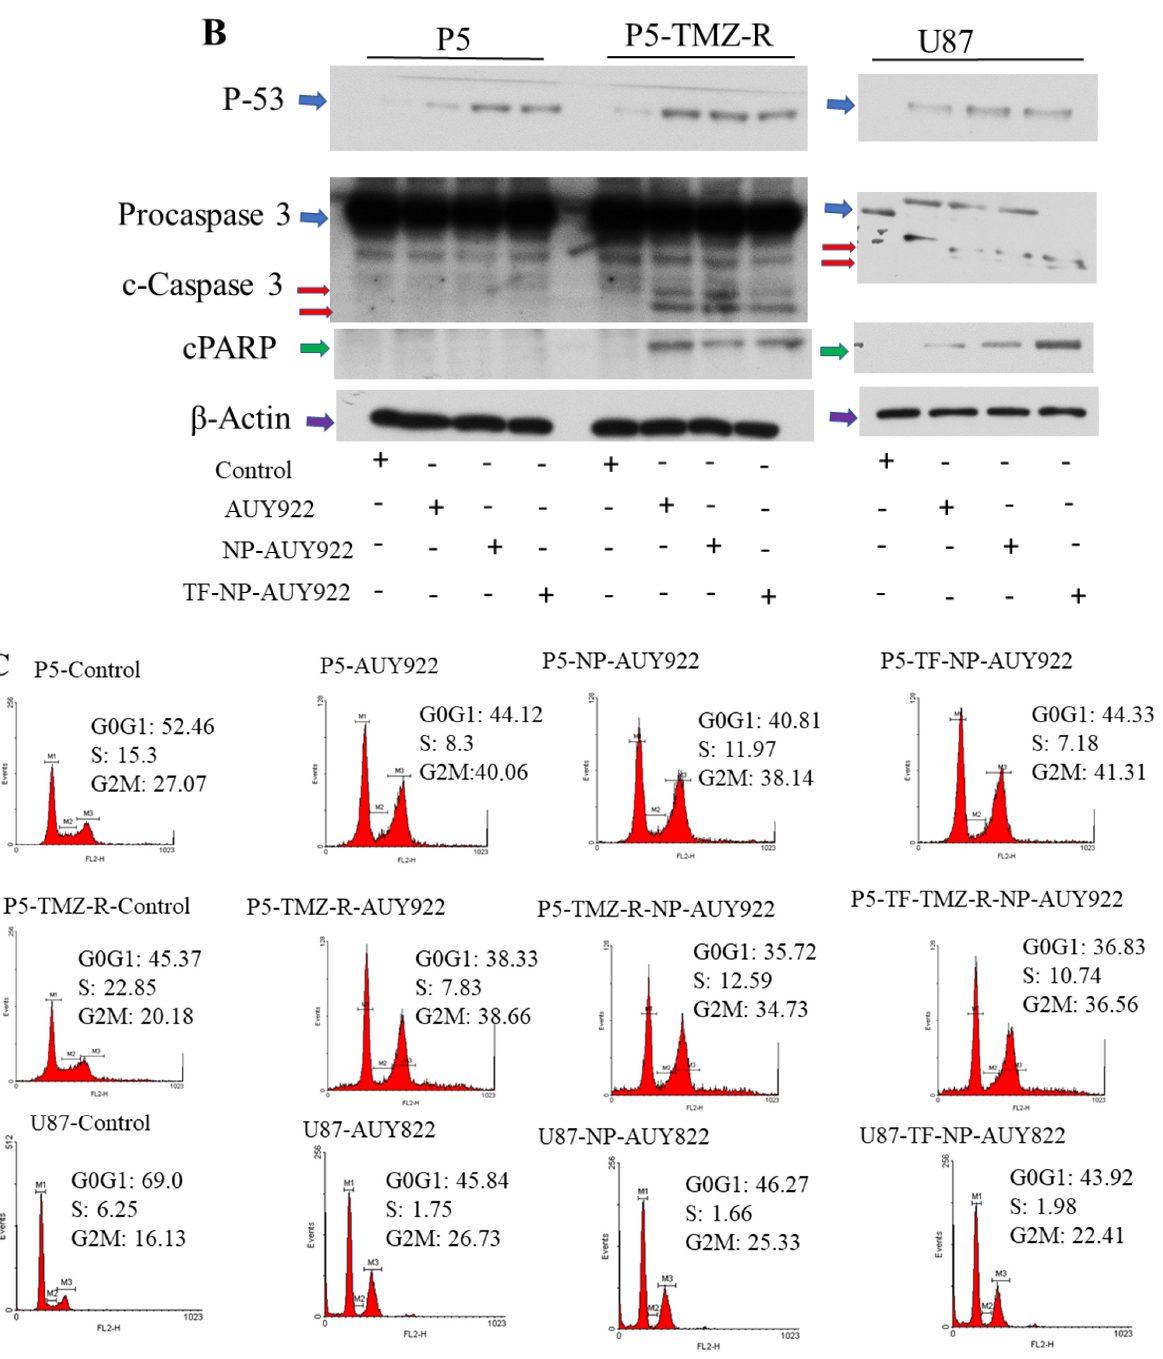
Figure 5. ( A ) Apoptosis assay of free AUY922, NP-AUY922, and TF-NP-AUY922 after 72 h of incubation at a concentration of 100 nM for free or nanoformulated AUY922. ( B ) Expression of P53, activation of caspase 3 (cleaved caspase 3), activation of PARP (cPARP) and β -actin proteins in P5, P5-TMZ-R, and U87 brain cancer cells after treating for 48 h using 100 nM free AUY922, NP-AUY922, and TF-NP-AUY922. ( C ) Cell cycle analysis of free AUY922, NP-AUY922, and TF-NP-AUY922 using P5, P5-TMZ-R, and U87 brain cancer cells after 48 h of incubation at a concentration of 100 nM for free or nanoformulated AUY922. In ( B ), the actin in the P5/P5-TMZ-R part of the experiment is identical as shown in Figure 7A, and the actin in the U87 part of the experiment is identical as shown in Figure 7A,B, because they are part of the same original blots probed with different antibodies of interest. The figures are re-organized as presented to better align with the data demonstrated in the Results